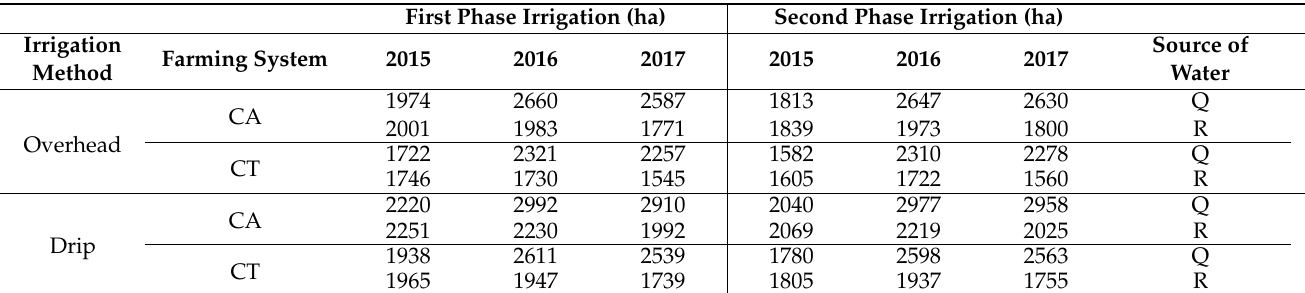
Table 3. Estimation of potentially irrigable land (hectares) using groundwater recharge (R) and runoff volume (Q) under overhead and drip irrigation application techniques under conservation agriculture (CA) and conventional tillage (CT) during 2015, 2016, and 2017.